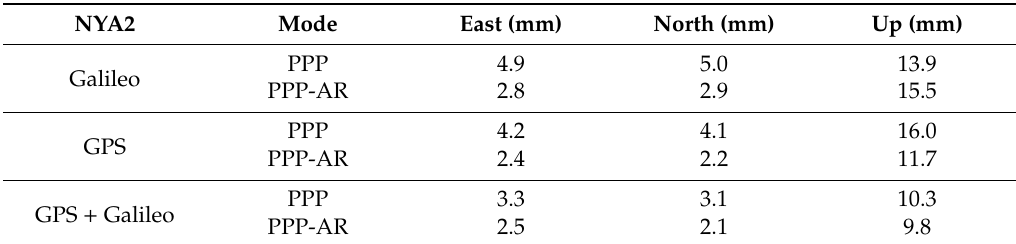
Table 6. 1- σ values PPP and PPP-AR for NYA2